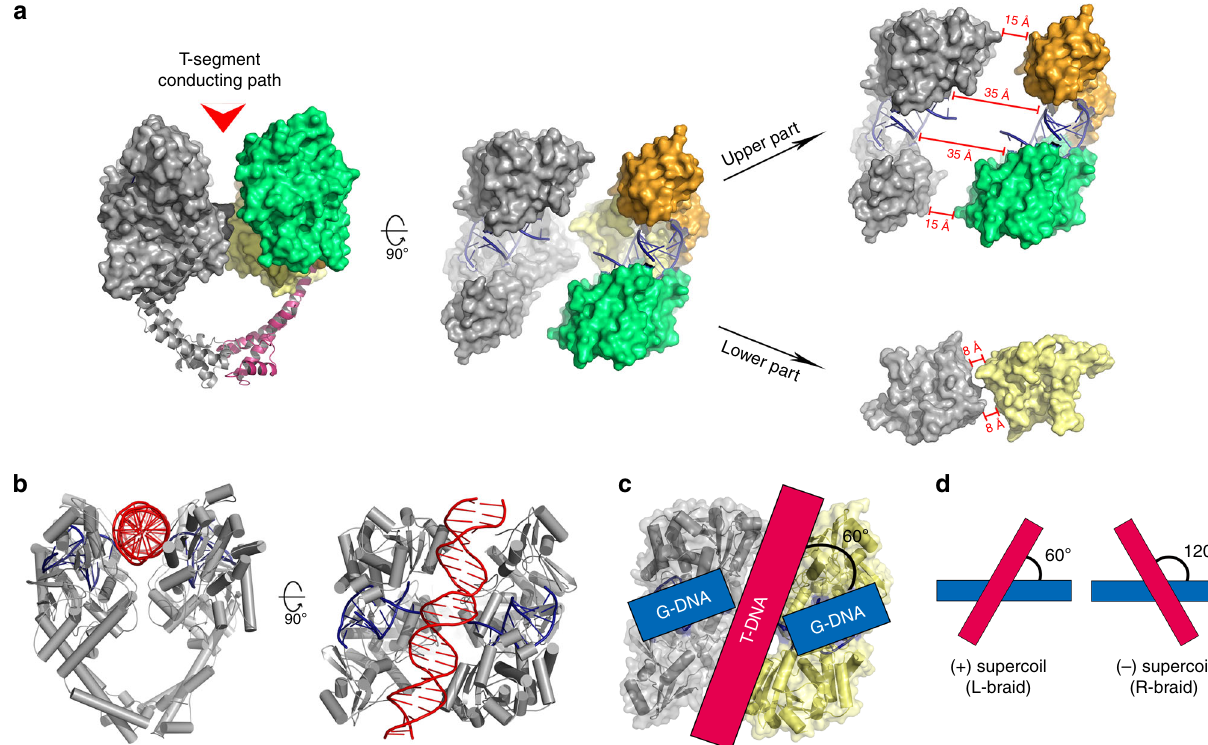
Fig. 4 Structural features of the T-segment-conducting path. a Based on the differences in width and shape, the T-segment-conducting path may be divided into two parts: an upper and wider part and a lower and narrower part. Compared to the upper part of the DNA-gate, the T-segment-conducting path de fi ned by the lower part inclines differently with respect to the G-segment, suggesting that the T-segment may undergo a counterclockwise rotation about the molecular dyad of Top2 as it moves across the DNA-gate. b A piece of B-form DNA can be introduced into the upper part of the T-segment conducting channel with no steric hindrance, giving a model that mimics the initial entry of the T-segment into the DNA-gate. c The ~60° inclination of the T-segment conducting channel about the G-segment resembles the left-handed crossover geometry often seen in positively supercoiled DNA ( d ). The two halves of the DNA-gate are colored differently according to the scheme used in Fig.